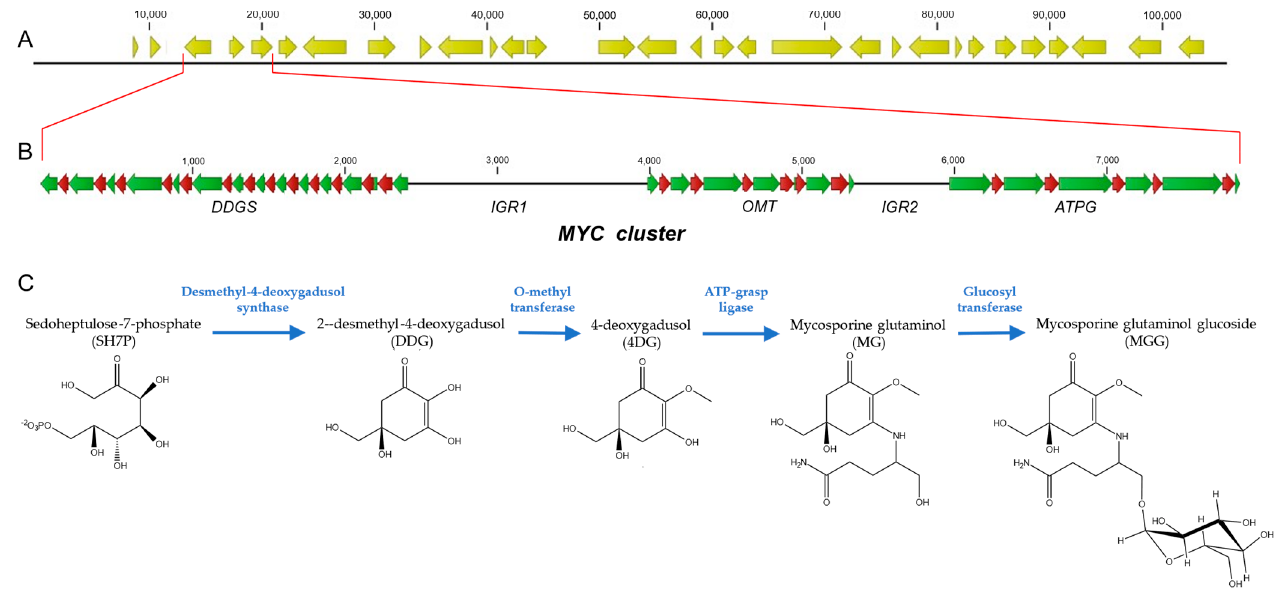
Figure 1. Graphical representations of the cluster of mycosporine genes from P. rhodozyma UCD 67-385. ( A ) A 100 kb region of the contig PacBio_000009 containing the MYC cluster at the left end. ( B ) Enlargement of the region containing the MYC cluster. The structural genetic organization of the DDGS , OMT, and ATPG genes is shown. ( C ) Mycosporine biosynthesis pathway. Green arrows: exons. Red arrows: introns. Thin black line: IGR1 and IGR2 .